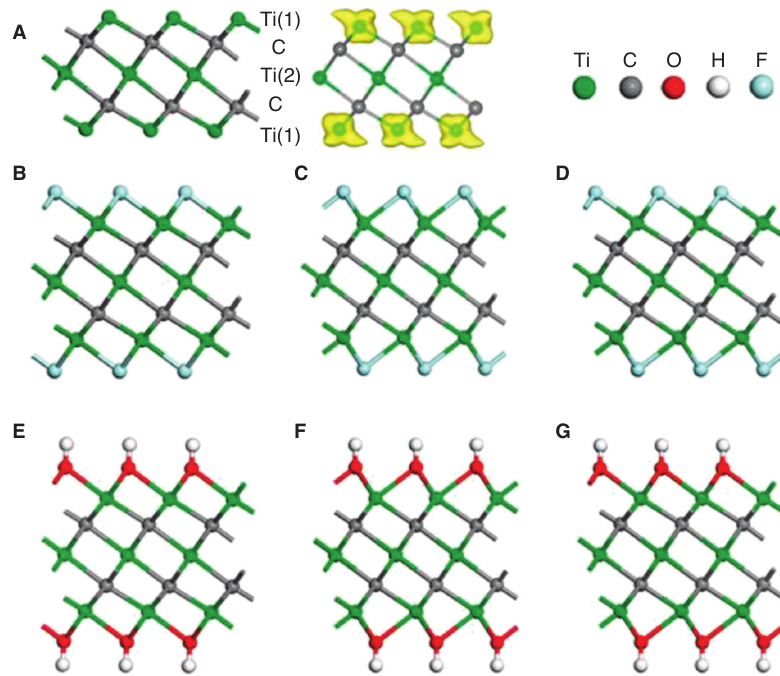
C microstructure. 3 2 C microstructure and (B–G) side view of the microstructure of Ti 3 2